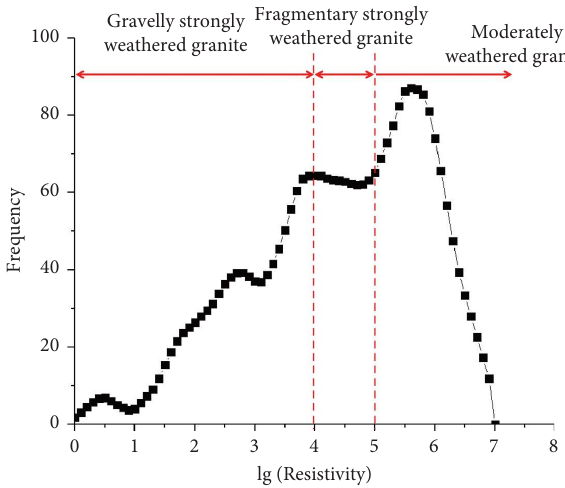
Figure 8: Resistivity frequency statistics.